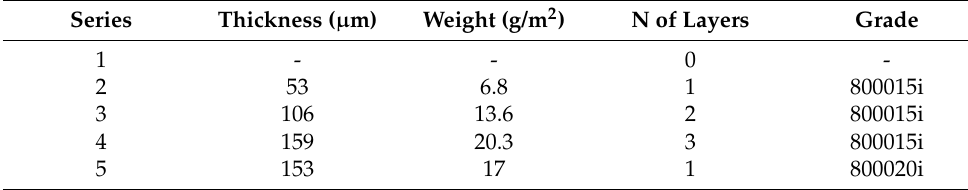
Table 1. Studied CFC compositions based on the manufacturer’s data. Series Thickness ( µ m) Weight (g/m 2 ) N of Layers Grade 1 - - 0 - 2 53 6.8 1 800015i 3 106 13.6 2 800015i 159